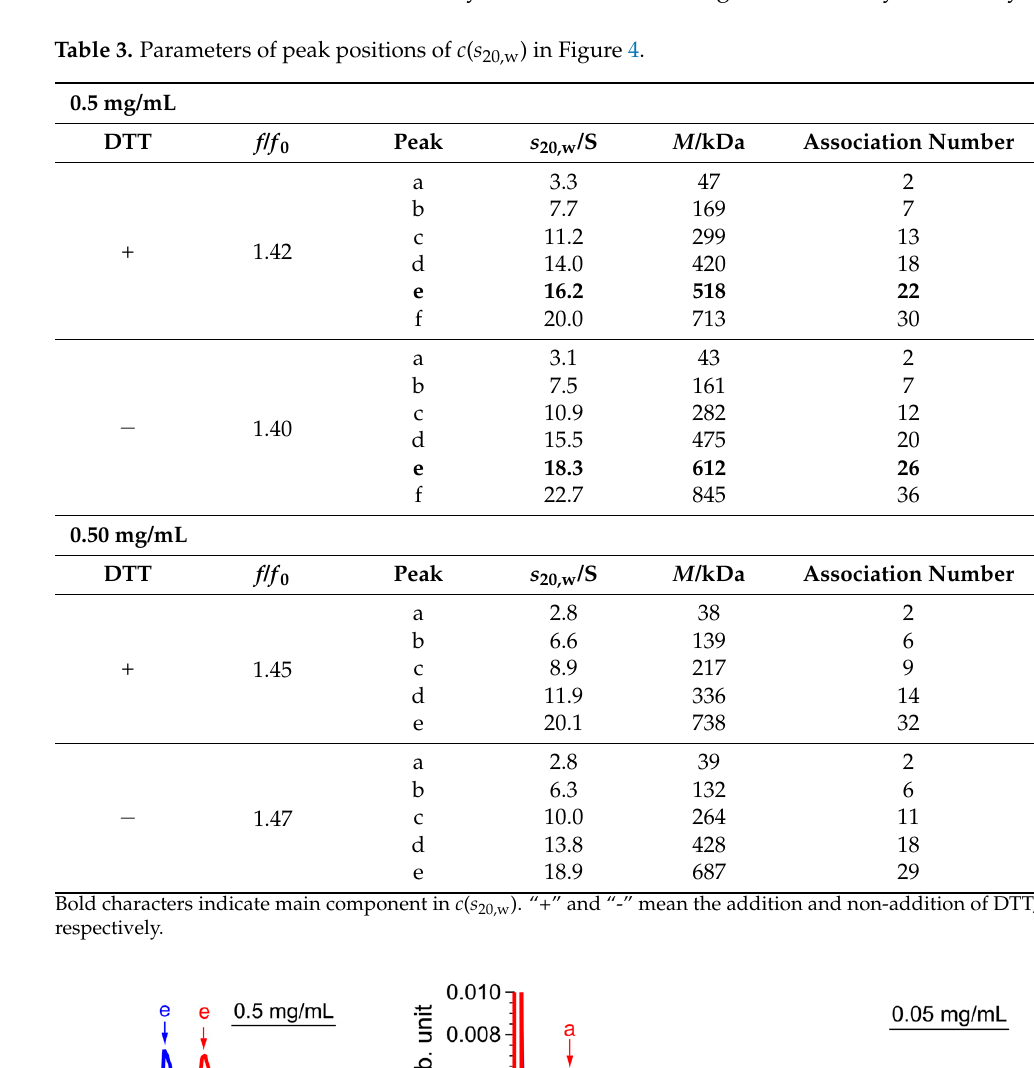
Table 3. Parameters of peak positions of c ( s 20,w ) in Figure 4.